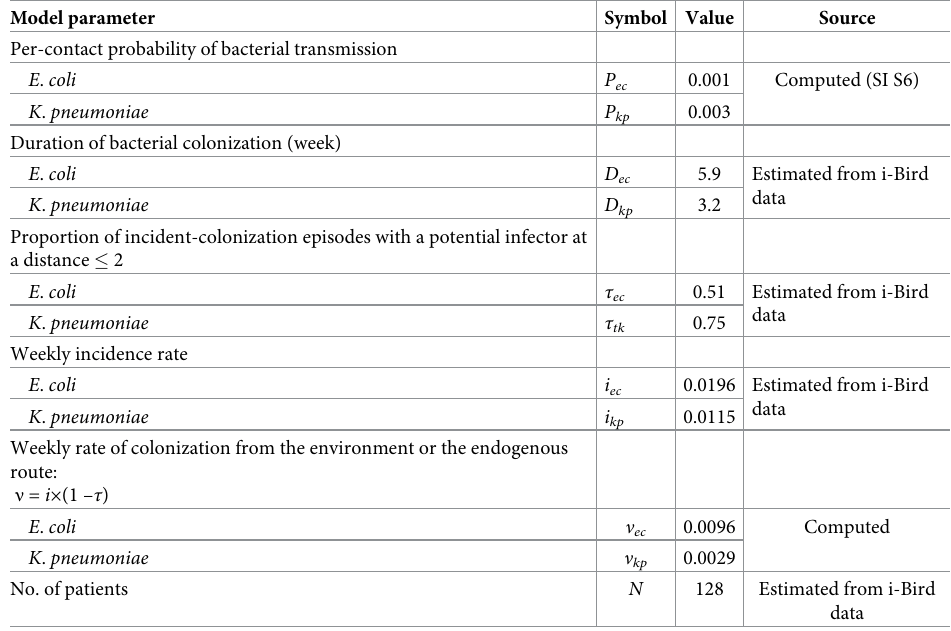
Table 4. Fixed model parameters.